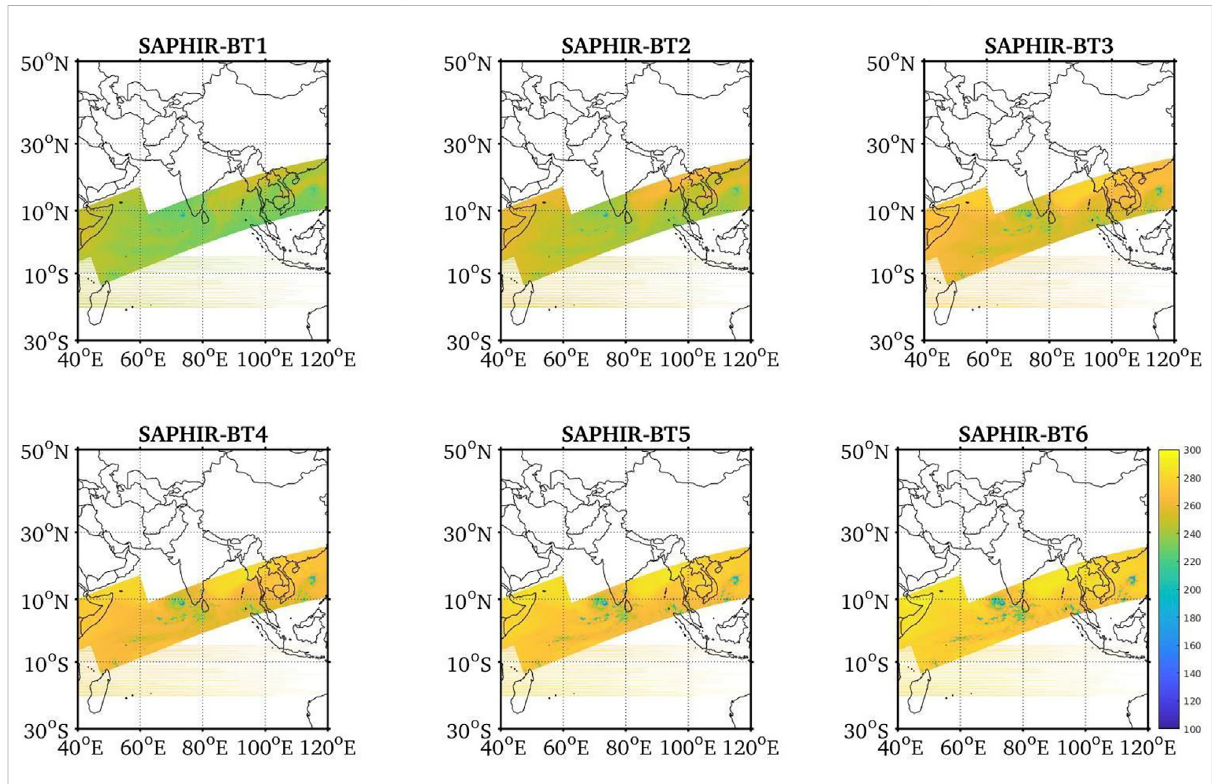
FIGURE 8 An overview of thebrightness temperaturedataset obtained from the6-channelsof SAPHIR, Megha-Tropiques satellite during thelifeof avery severe cyclonic storm Ockhi (29 November 2017 – 6 December 2017) over the